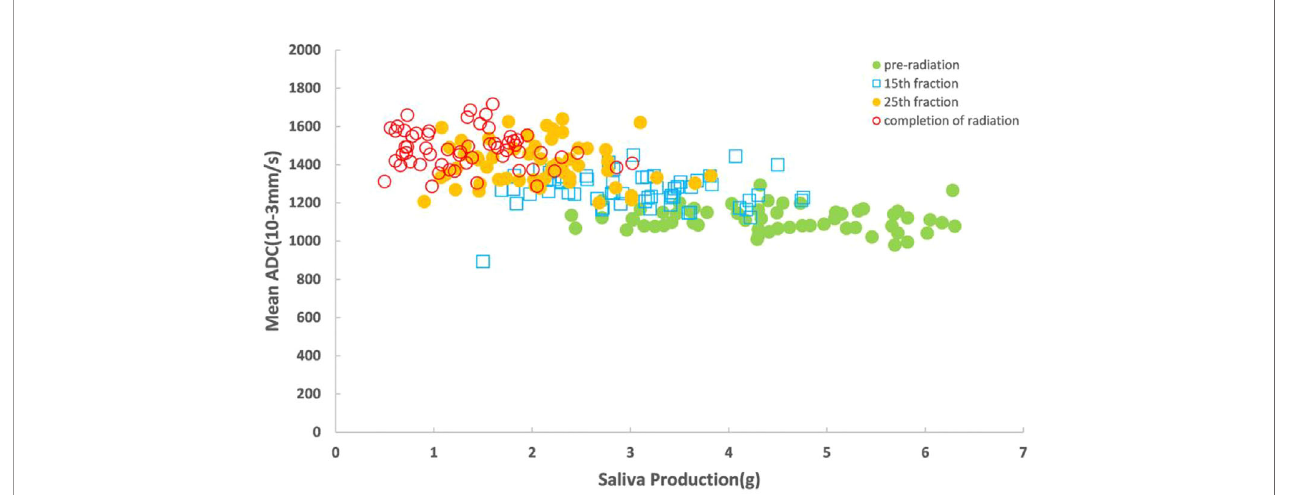
FIGURE 4 | Correlation between mean 3D-ADC value for the saliva